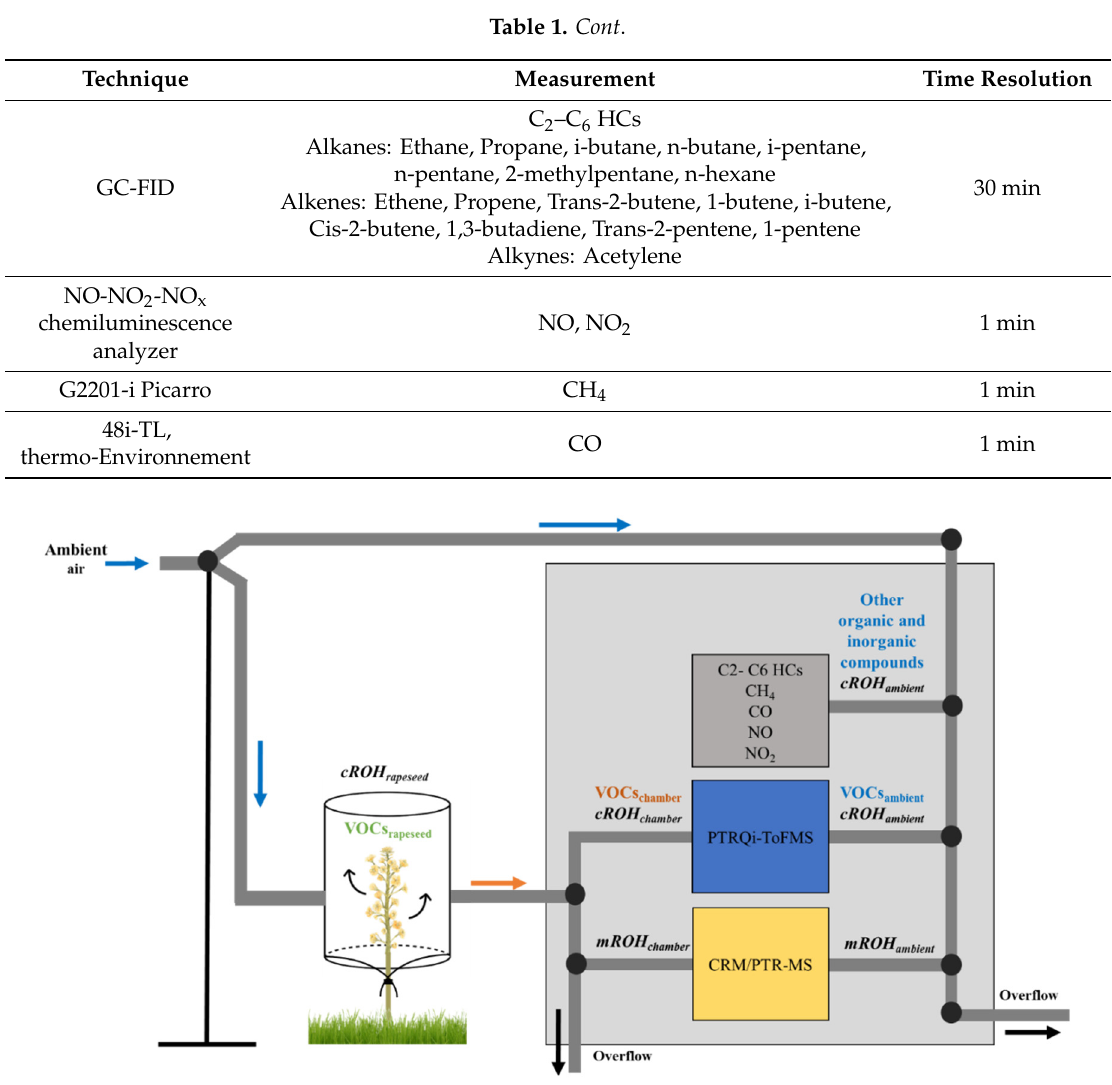
Figure 2. Schematic representation of the system used for the measurements in the incoming and the outgoing chamber air. mROH ambient and mROH chamber stand for measured OH reactivity in the incoming and the outgoing air, respectively. cROH ambient and cROH chamber represent the calculated OH reactivity in the incoming and the outgoing chamber air, respectively. cROH rapeseed is calculated using VOCs rapeseed , determined from VOCs chamber − VOCs ambient (both measured with the PTRQi-ToFMS).